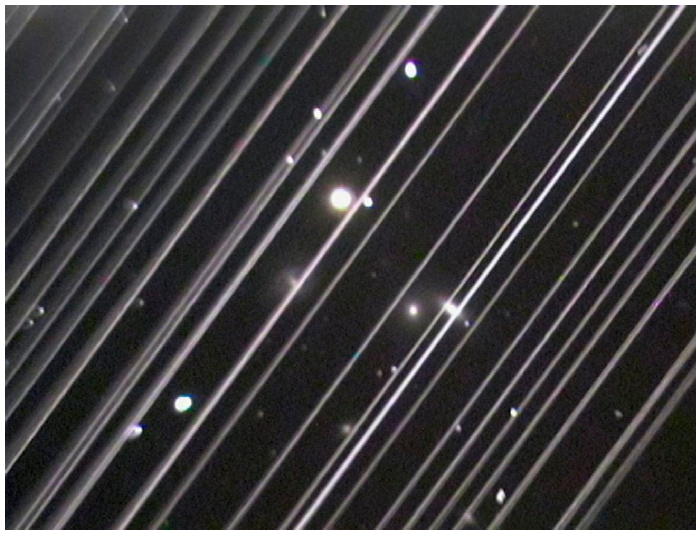
Figure 5. Galaxy group NGC 5353/4 seen with a telescope at Lowell Observatory in Flagstaff with Starlink satellites passing in front, Arizona, on 25 May 2019 (Courtesy of EarthSky Voices).